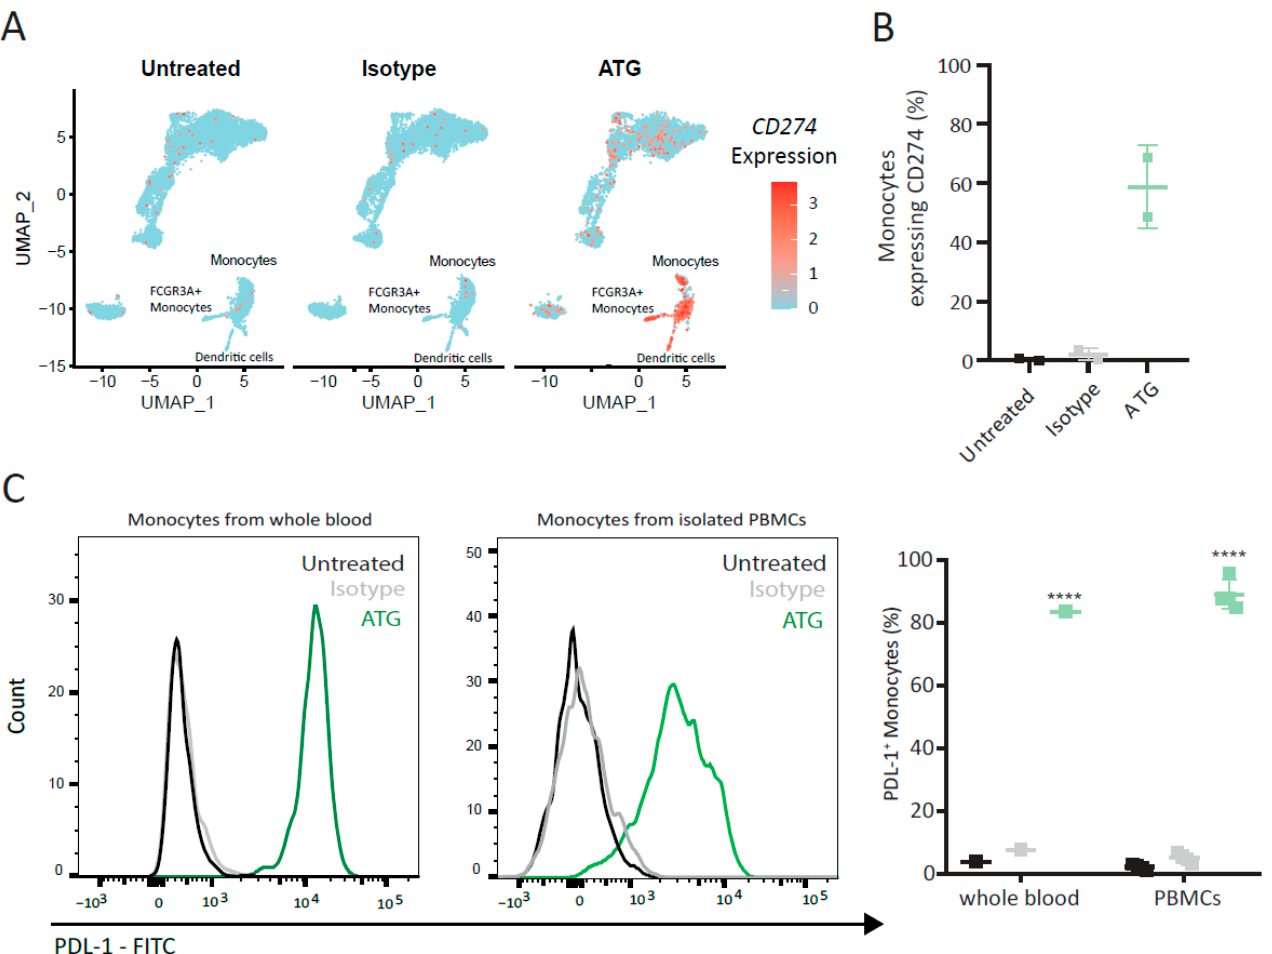
Figure 2. ATG upregulates CD274 in monocytes from whole blood ex vivo. ( A ) Feature plot for CD274 of untreated, isotype- and ATG-treated white blood cells. Monocytes, FCGR3A + monocytes and dendritic cells are annotated and the red colour gradient indicates the expression level. ( B ) Bar plot showing the mean percentage of monocytes expressing CD274 and standard error of the mean (SEM) in Untreated, Isotype and ATG. N = 2 donors. ( C ) Flow cytometry analysis for the PDL-1 of ATG-treated whole blood and purified PBMCs. Histogram showing monocytes of Untreated (black), Isotype (grey) and ATG (green) from whole blood and purified PBMCs. **** indicates p - value < 0.0001.